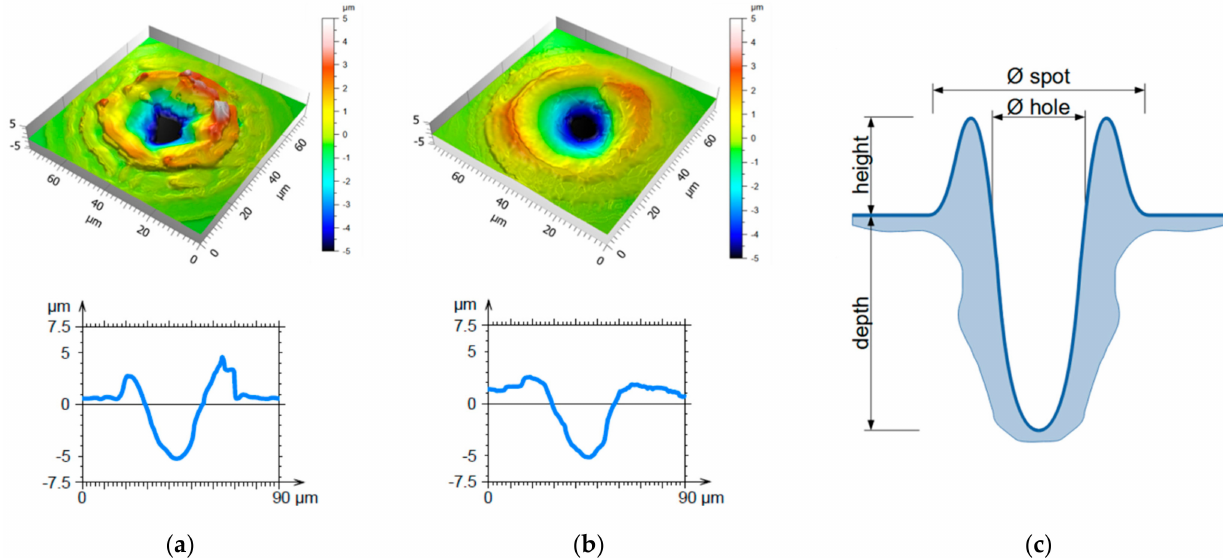
Figure 3. Confocal images and profiles of spots processed with DLW using ( a ) 70 pulses with a pulse duration of 8 ns and ( b ) 400 pulses at 200 ns. The laser fluence was kept constant at of 0.44 J/cm 2 . The resulting holes had a depth of approximately 5.0 µ m in both cases. ( c ) Schematical drawing of the cross section of a laser processed spot defining the structure depth, height of molten material, and spot and hole